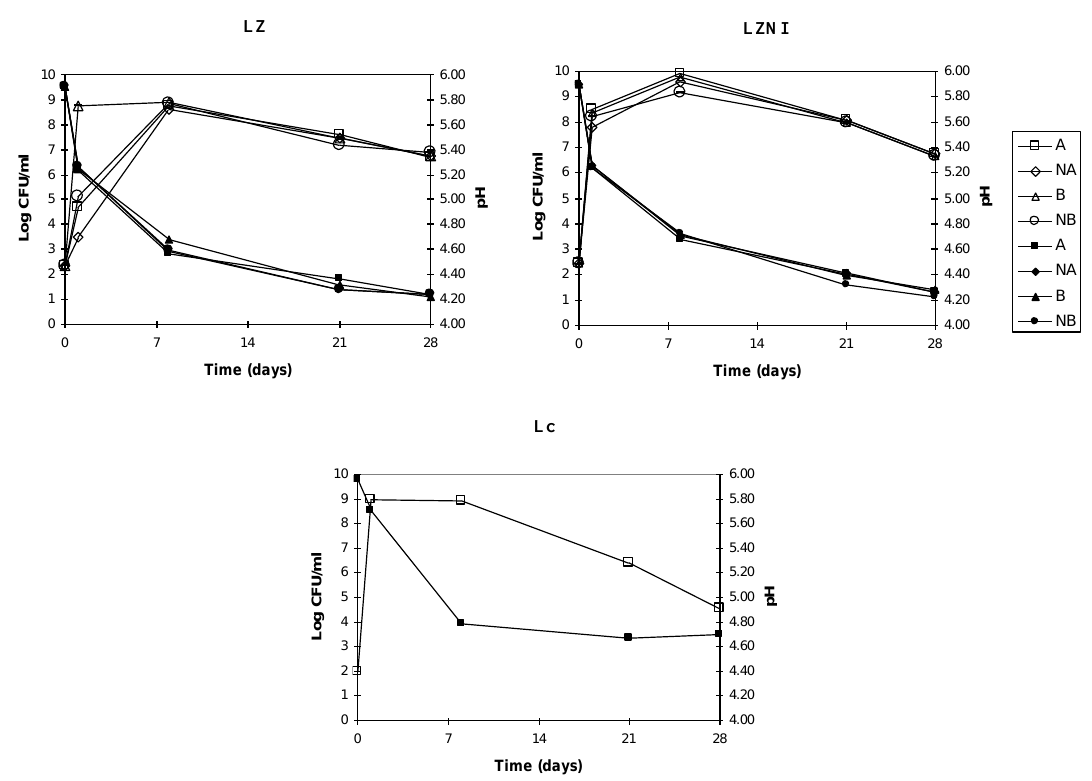
Figure 1. Growth and pH values in co-cultures of L. plantarum LZ or LZNI with L. lactis subsp. lactis DSM 20729 (Lc):B, combination L. plantarum /nisin producer 102:102 CFU mL −1 ; NB, combination B with 10 IU/mL of nisin added; A, combination L. plantarum /nisin producer 102:104 CFU mL −1 ; NA, combination A with 10 IU/mL of nisin added. Open symbols: Count values; solid symbols: pH values.